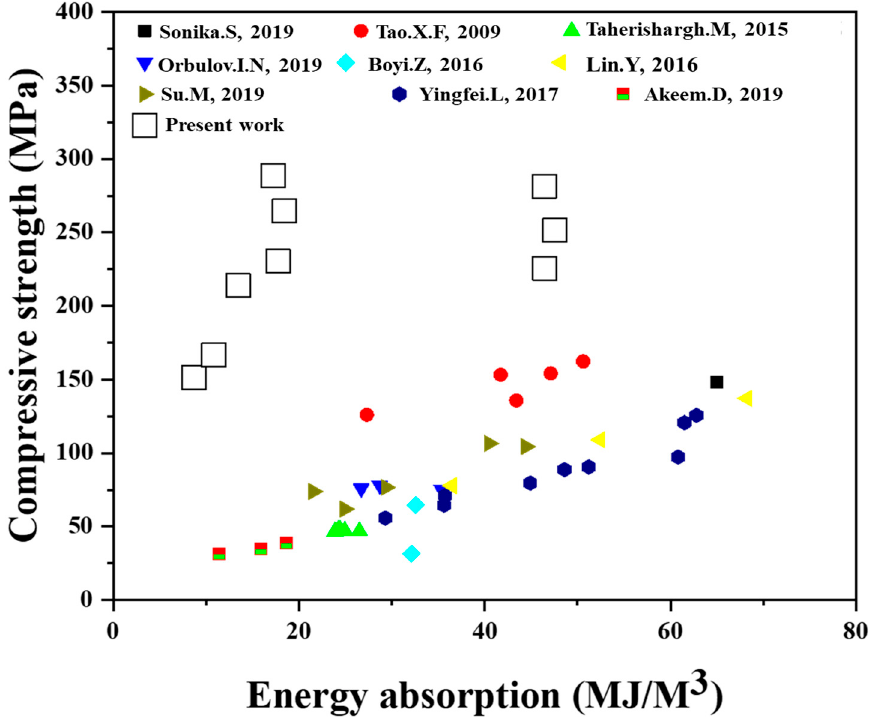
Figure Figure 15. Comparison of results obtained from the present study with other literature data [6,41,44,47–52].